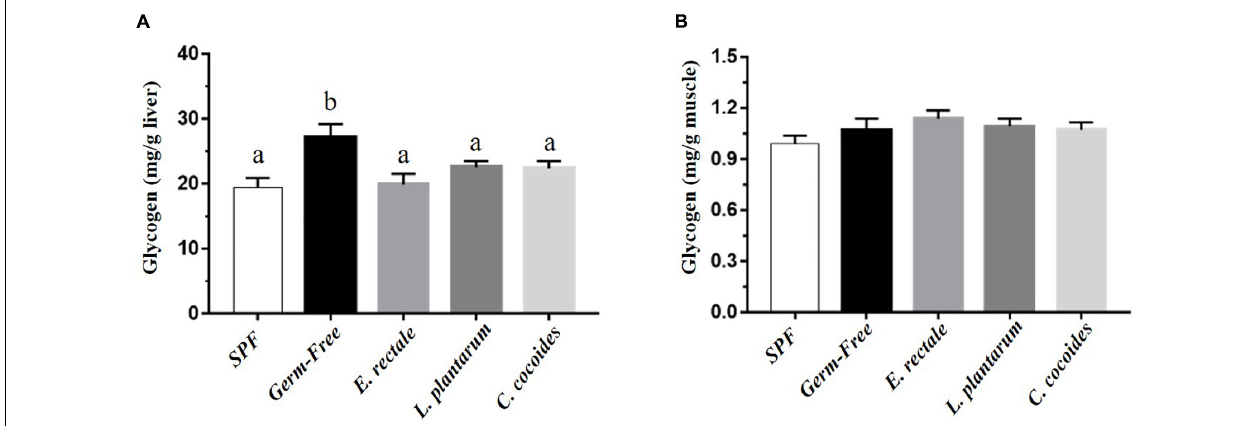
FIGURE 7 | Effect of indicated gnotobiotic groups on hepatic (A) and muscle (B) glycogen level. Data are mean ± SEM ( n = 6–8/group) and the columns with different superscript letters (a,b) are significantly different at P < 0.05.